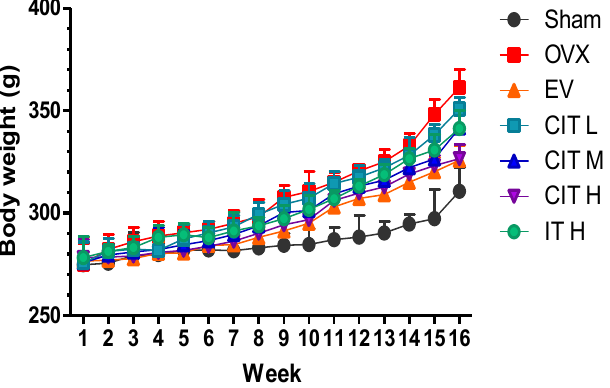
Figure 2. Body weight changes in the OVX model of osteoporosis. OVX rats received no treatment (OVX), EV (100 μg/kg/day), CIT (10, 20 and 40 mg/kg/day), and IT (40 mg/kg/day) for 12 weeks. Values were mean ± SD, error bars in the figure are presented as SD, n = 8. OVX compared with Sham p < 0.01, EV, CIT-H, CIT-M, IT compared with OVX p < 0.05, CIT-H compared with IT p <